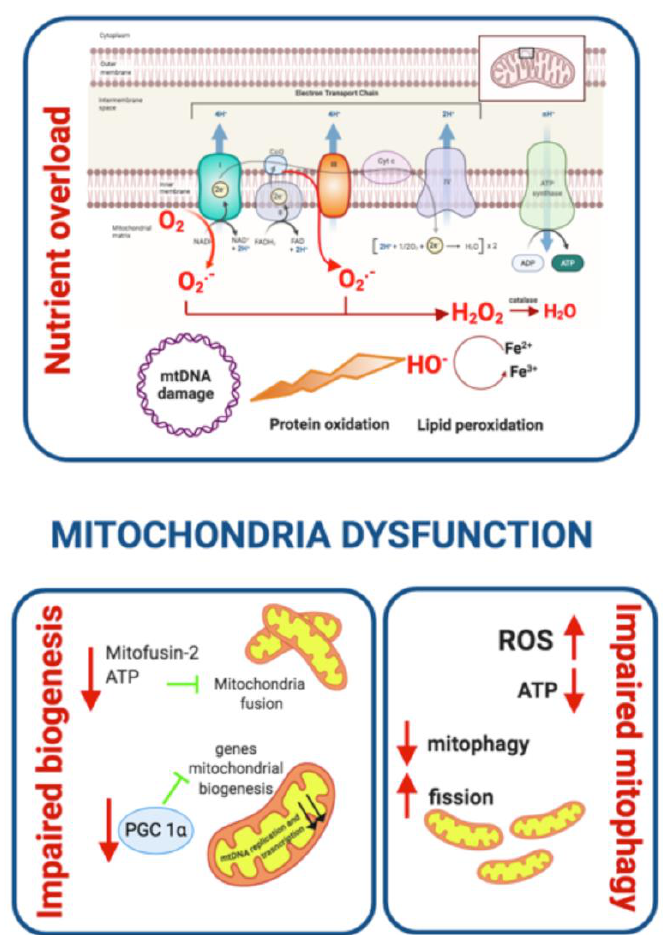
Figure 3. Mitochondrial dysfunction and contribution to T2DM development. Oxidative stress, defective mitochondrial biogenesis and impaired mitophagy promote mitochondrial dysfunction. Generation of ROS links mitochondrial dysfunction and IR. As a consequence of nutrient